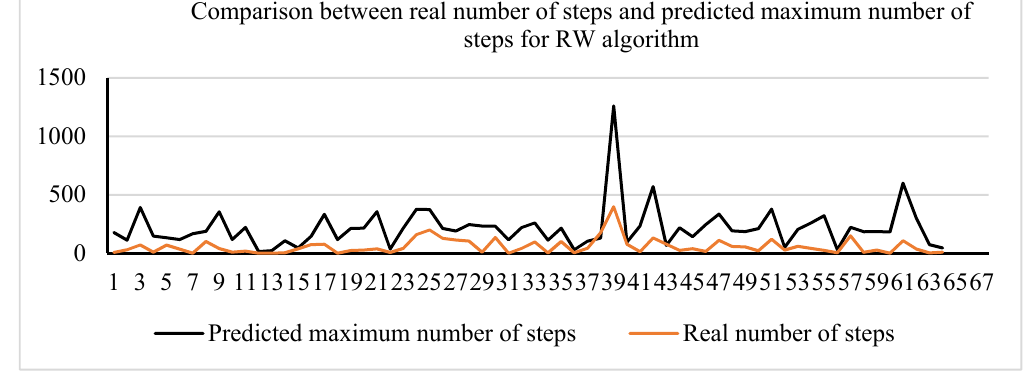
Figure 11. Comparison between real number of steps and predicted maximum number of steps for RW algorithm.